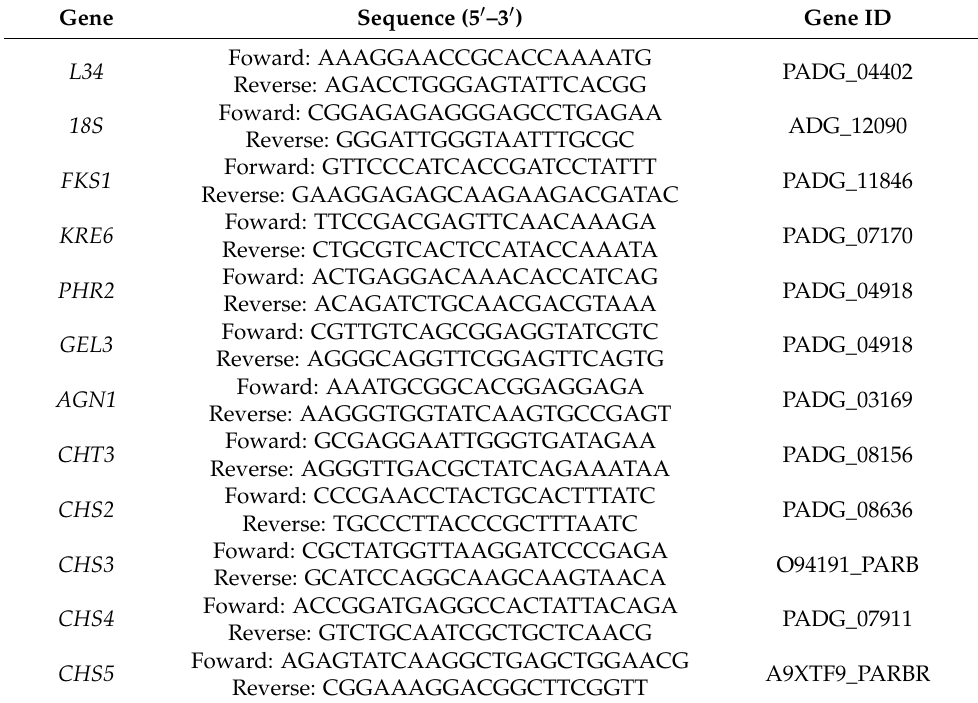
Table 1. Oligonucleotides used for real-time quantitative PCR